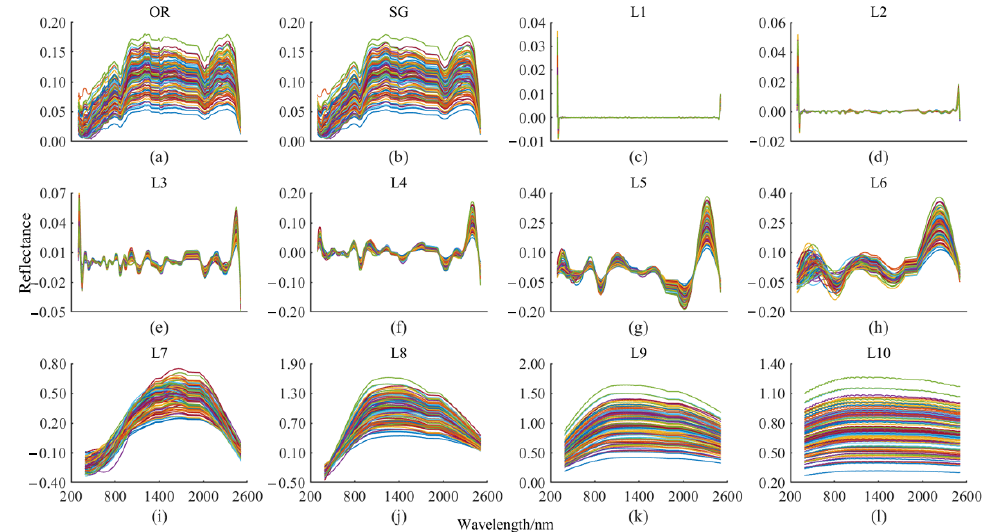
Figure 4. Original and pretreated soil reflectance curves. (Notes: ( a ) OR is the original soil reflectance curve; ( b ) SG denotes the soil reflectance curve smoothed by SG; ( c – l ) L1–L10 are the reconstructed spectra using CWT at decomposition scales of 1–10).